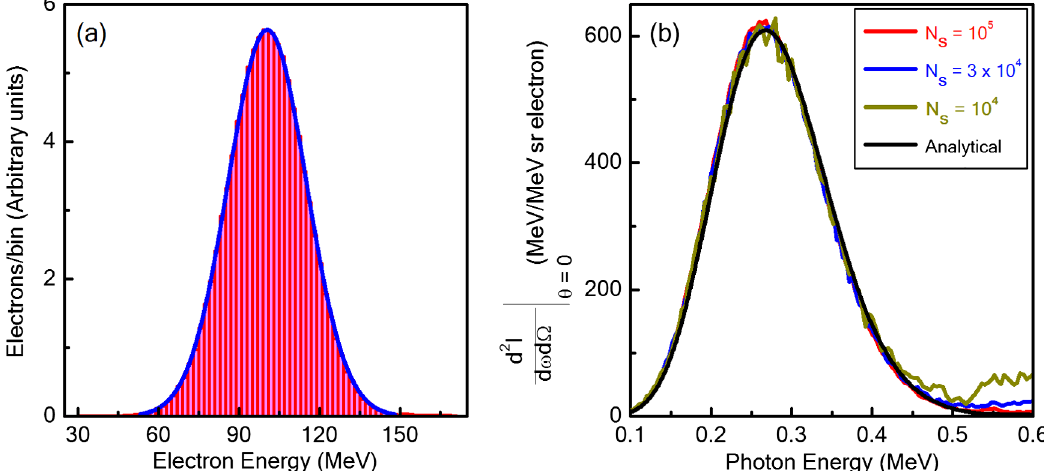
FIG. 1. Histogram of electron beam energy distribution (a), and the corresponding on-axis Thomson scattered radiated energy density (b) calculated numerically with an electron beam sampled with N s ¼ 10 4 (dark green), N s ¼ 3 (cid:3) 10 4 (blue), N s ¼ 10 5 (red), and analytic estimate (black). The scattering laser intensity is 9 (cid:3) 10 16 W = cm 2 , (cid:2) 0 ¼ 800 nm , and (cid:6) ¼ 90 fs . The energy spread of the electron beam is 34%, and the corresponding Thomson bandwidth is 66%. The scattered number of photons per electron per unit solid angle is